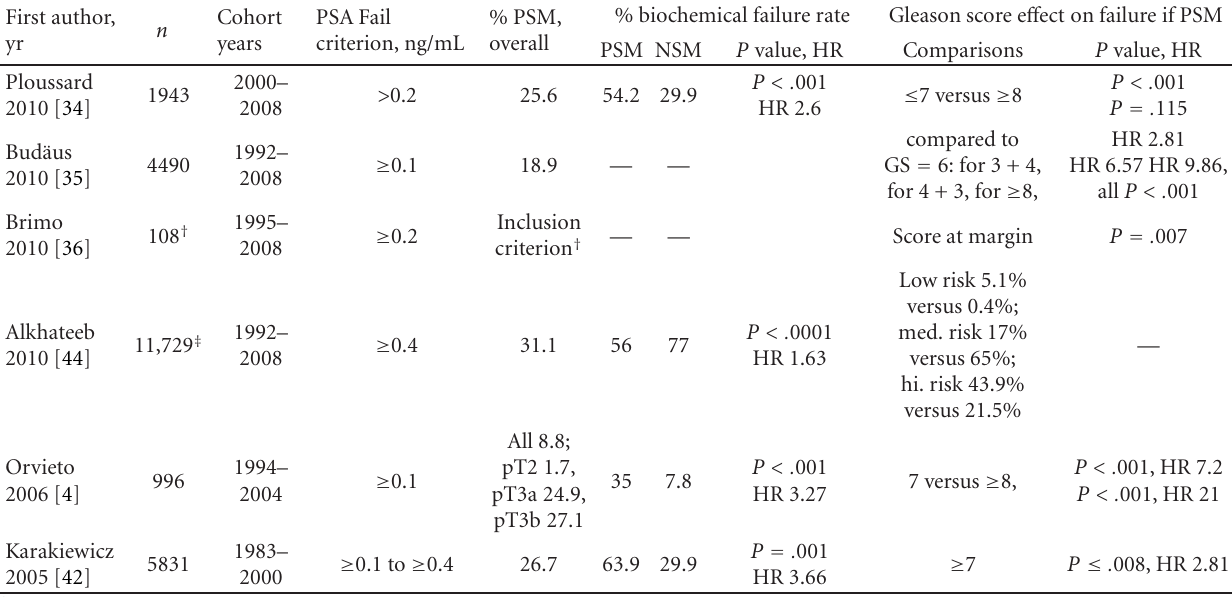
Table 5: Modification of PSA failure rates according to grade, at 10 years (unless specified).